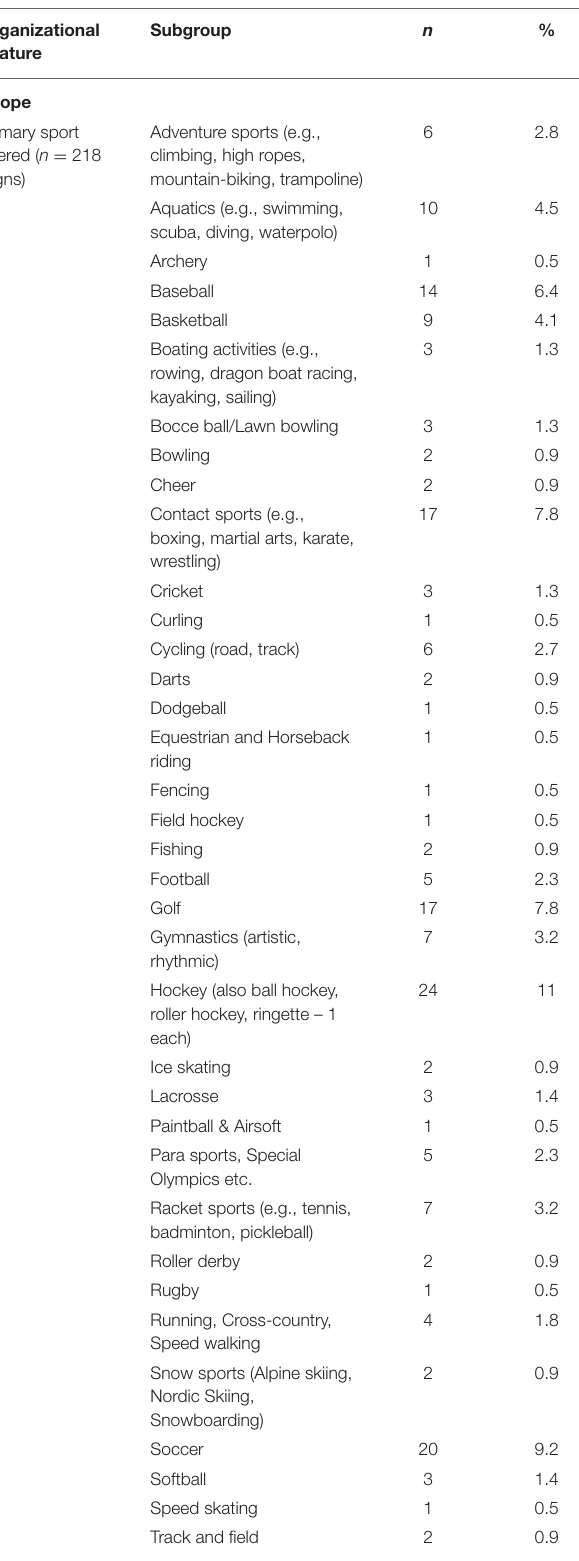
TABLE 2 | Profile of private community sport organizations in London,